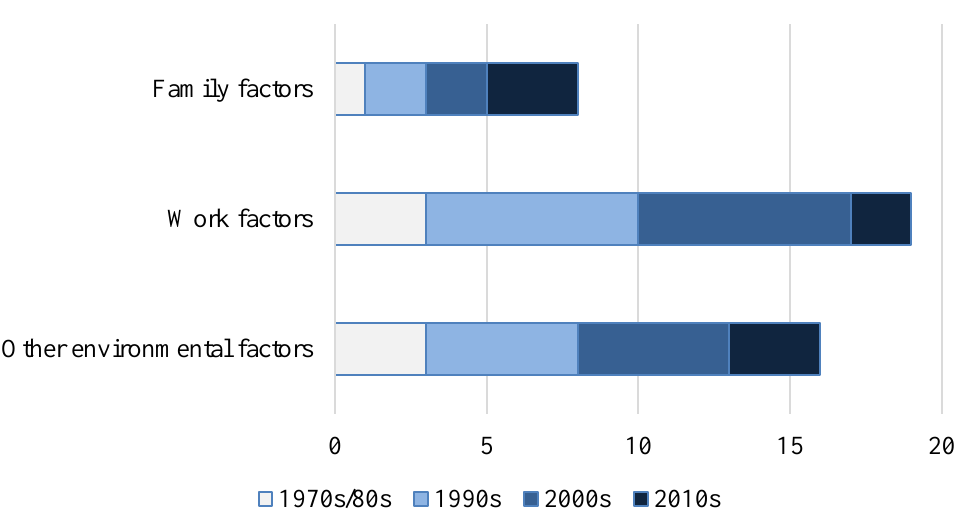
Figure 7. Frequency count of the subcategories of environmental factors in various